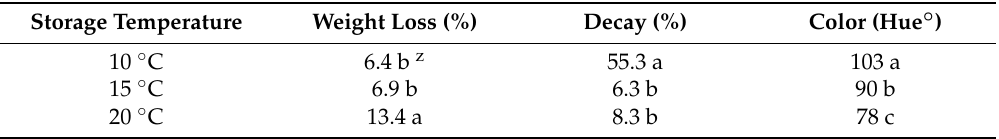
Table 1. The influence of storage temperature on Acorn squash quality parameters after 2.5 months in cold storage plus 3 days at 20 ◦ C.